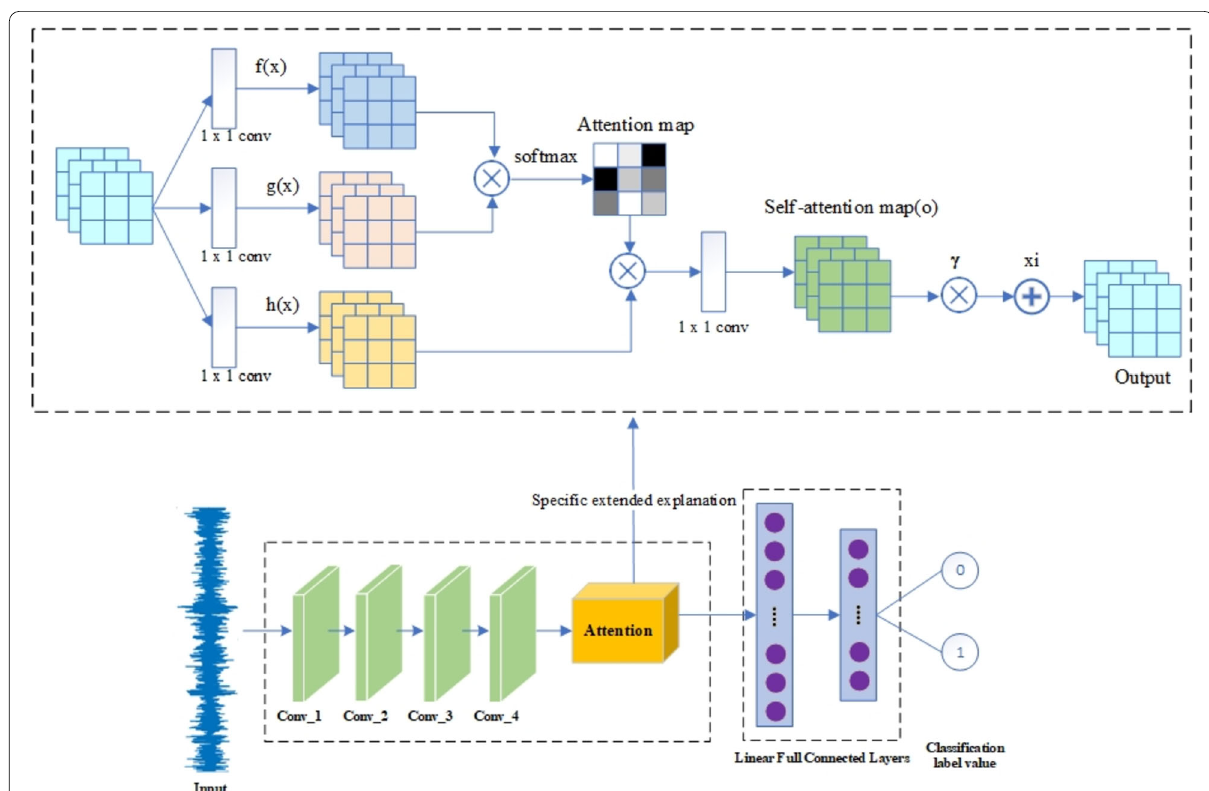
Figure 3 Network